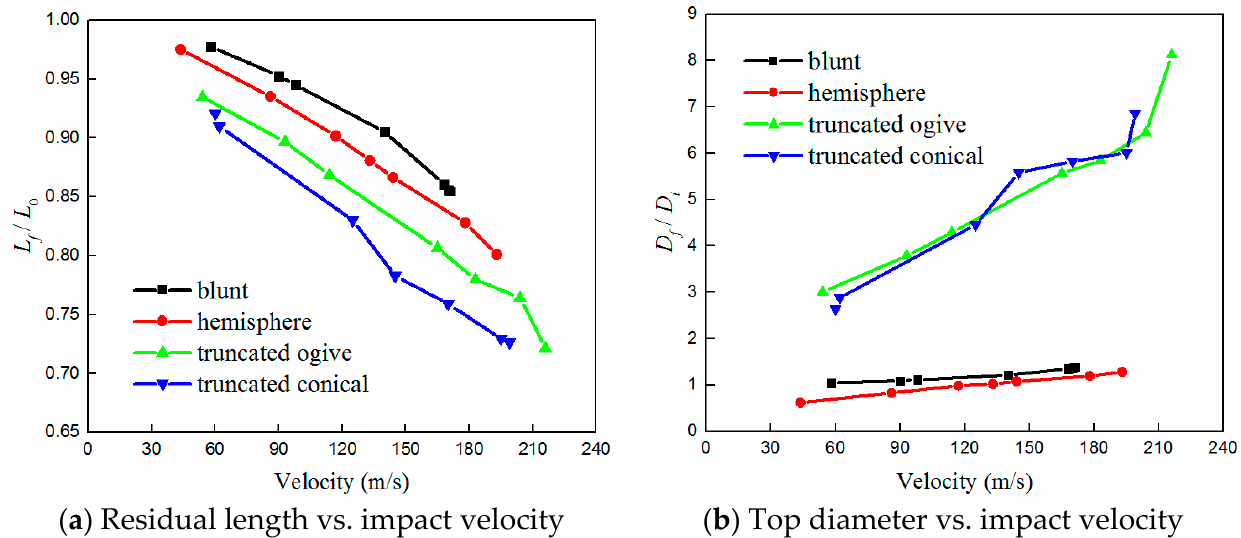
Figure 13. Comparison of external contour changes.